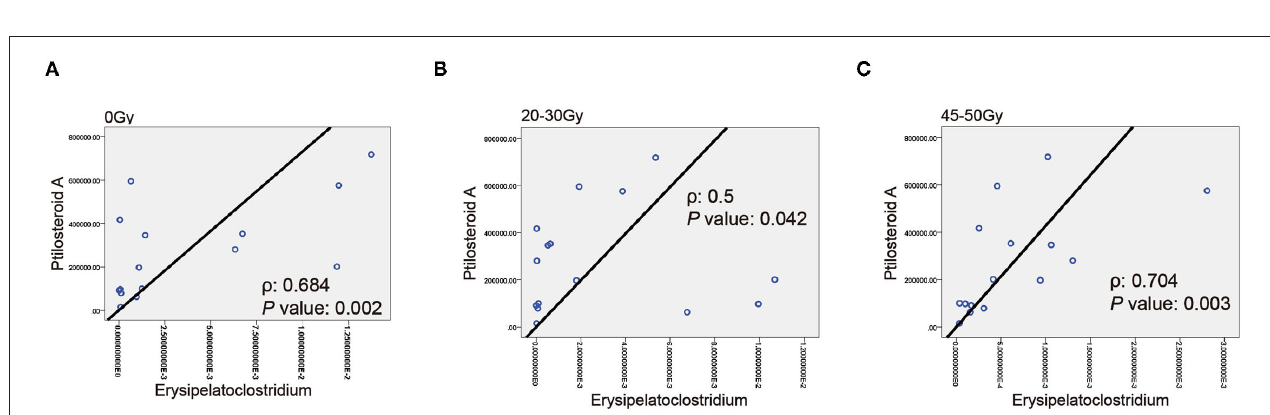
FIGURE 6 | Associations between Erysipelatoclostridium and ptilosteroid A. (A–C) The correlation between gut Erysipelatoclostridium relative abundance and ptilosteroid A expression at all the three timepoints by Spearman’s correlation analysis. Solomon Islands in 2009 (22). Currently few articles about the function of ptilosteroid A has been reported, but the key role that lipids play in maintaining of gut epithelial integrity has